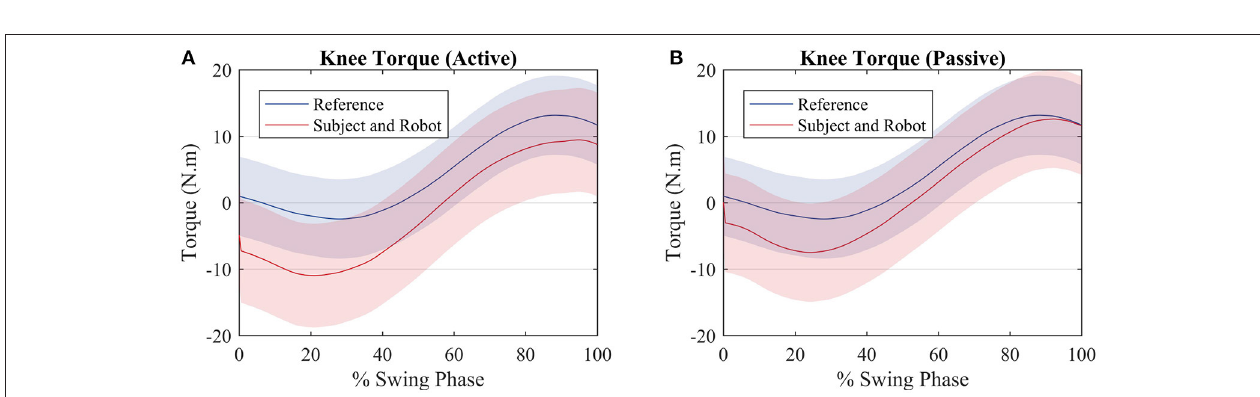
FIGURE 7 | Average torque exerted by the subjects (red) and average torque value used to compute the reference (blue) for an (A) active walk and a (B) passive walk. Shaded regions denote the standard deviation of the measurements.